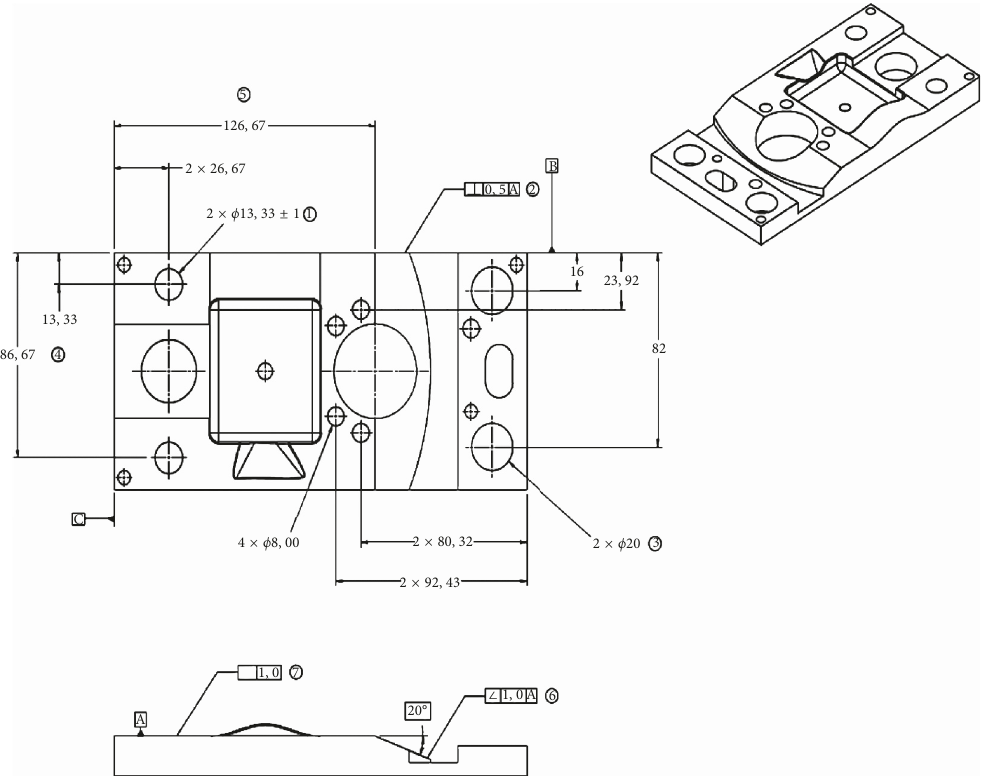
Figure 2: GD&T of the sample part with numbering